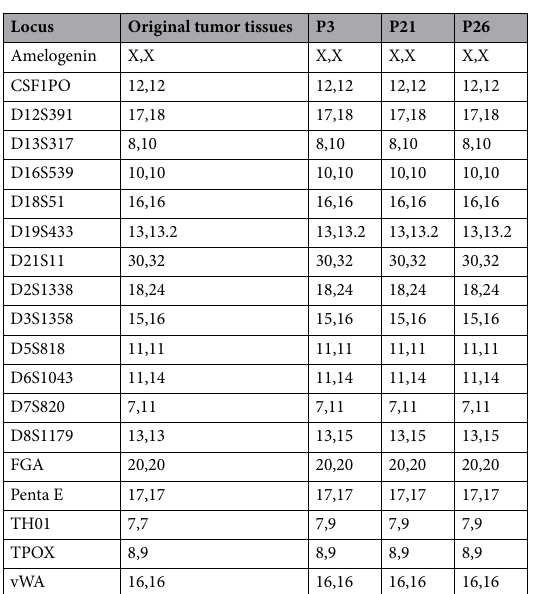
Table 1. STR profiles of the original tumor tissues and PUMC-CRC1 cells at different